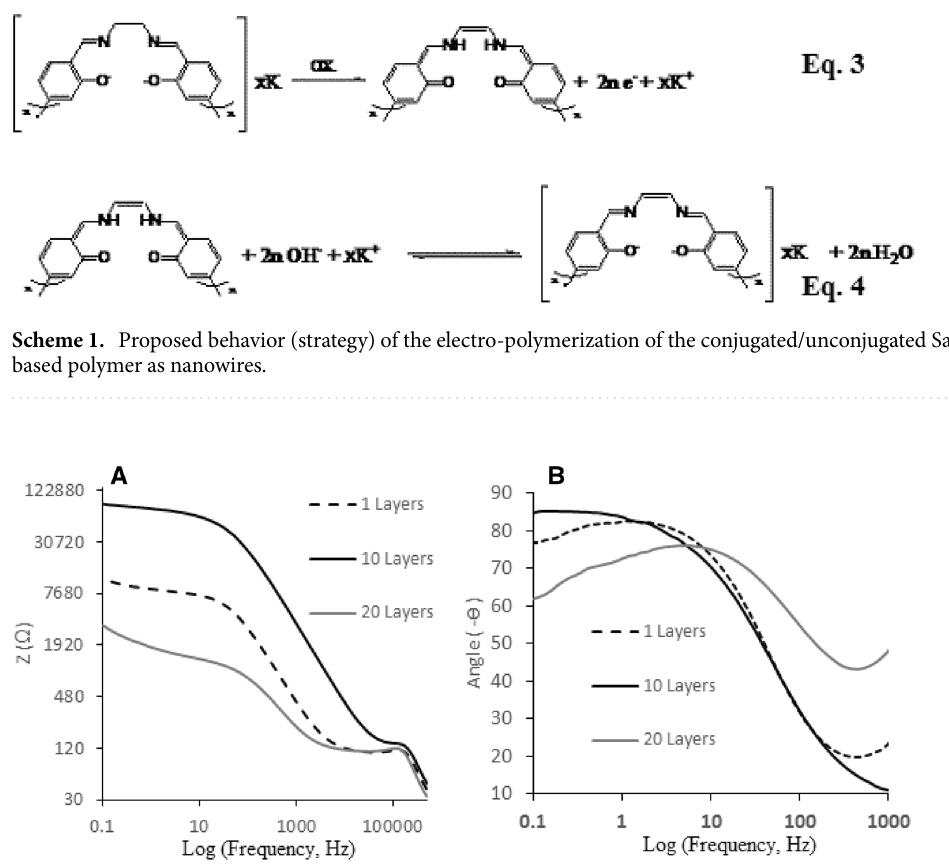
Figure 4. Diagrams of real impedance and phase angle vs. frequency (Bode and angle-frequency plots of conjugated/unconjugated Salen-based polymer as nanowires modified on the surface of GC electrode through the electrosynthetic